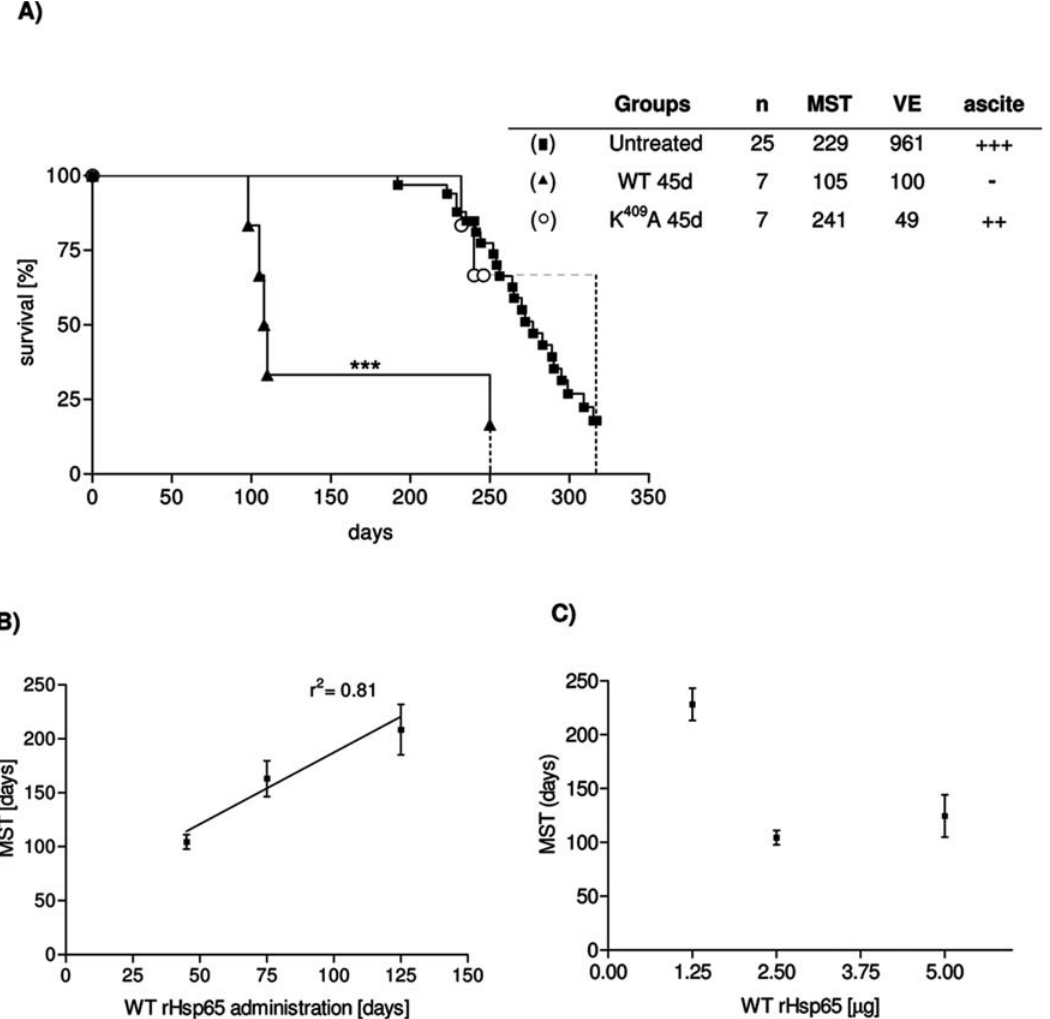
Figure 1. Effect of the WT and K 409 A rHsp65 treatment on SLE. Effect of the WT rHsp65 administration on survival time [A]. Female [NZBxNZW]F 1 mice were treated or not [ & ] with a single dose [2.5 m g] of WT [ m ] or K 409 A [ # ]rHsp65 at 45 days of age. Age-dependence effect of the WT rHsp65 treatment on MST [B]. Dose-dependence of WT rHsp65 on F 1 MST [C]. MST [Mean survival time; days]; VE [environmental variance];